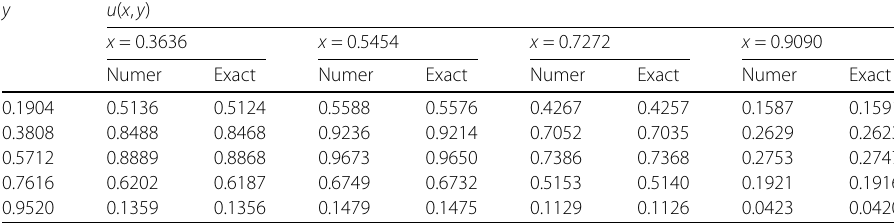
Table 6 Comparison of numerical and analytical results for Example 7.3 y u ( x , y ) x = 0.3636 0.1904